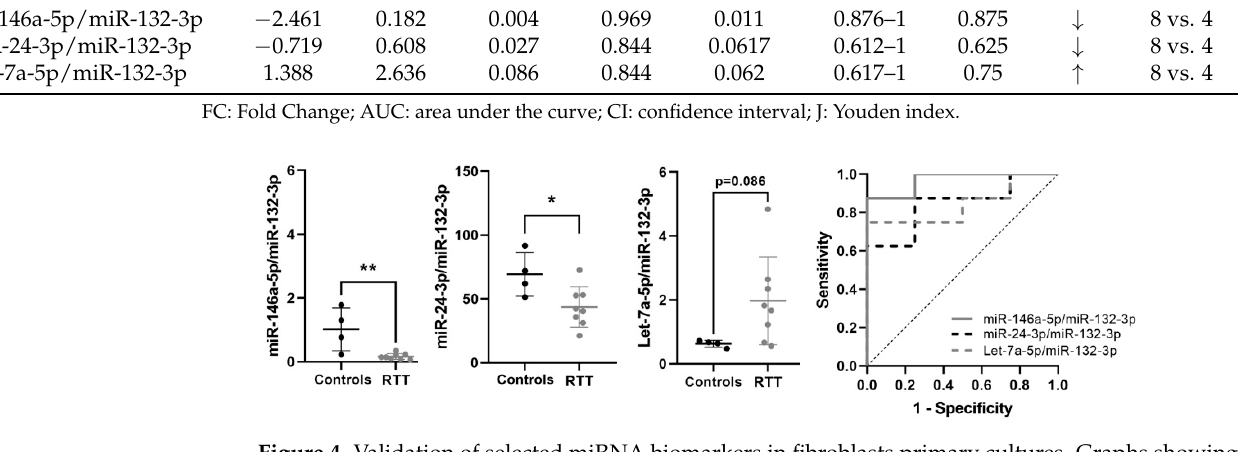
RTT vs. Controls